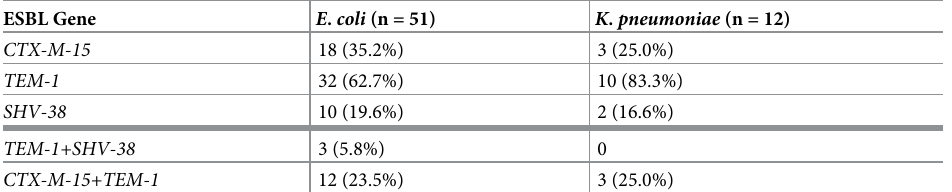
Table 5. Frequency of ESBL genes among ESBL-producing E . coli and K . pneumoniae